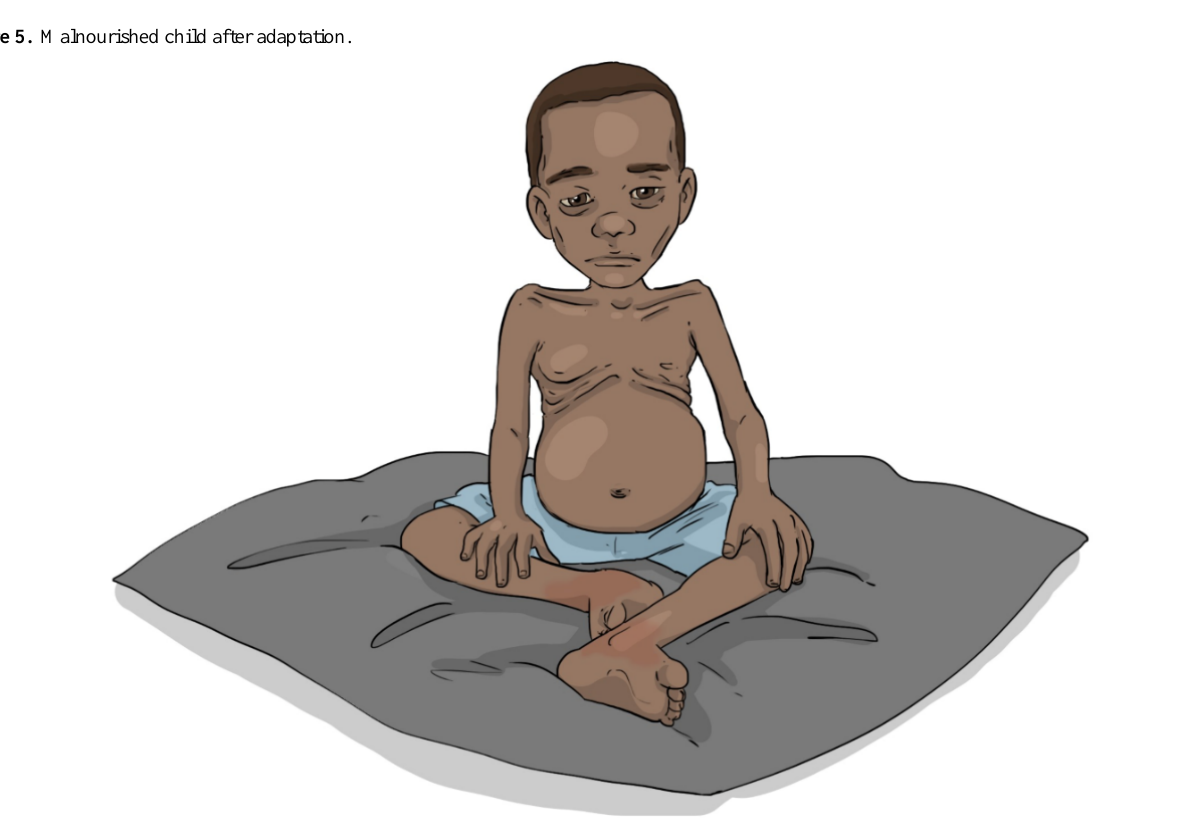
Figure 5. Malnourished child after adaptation.